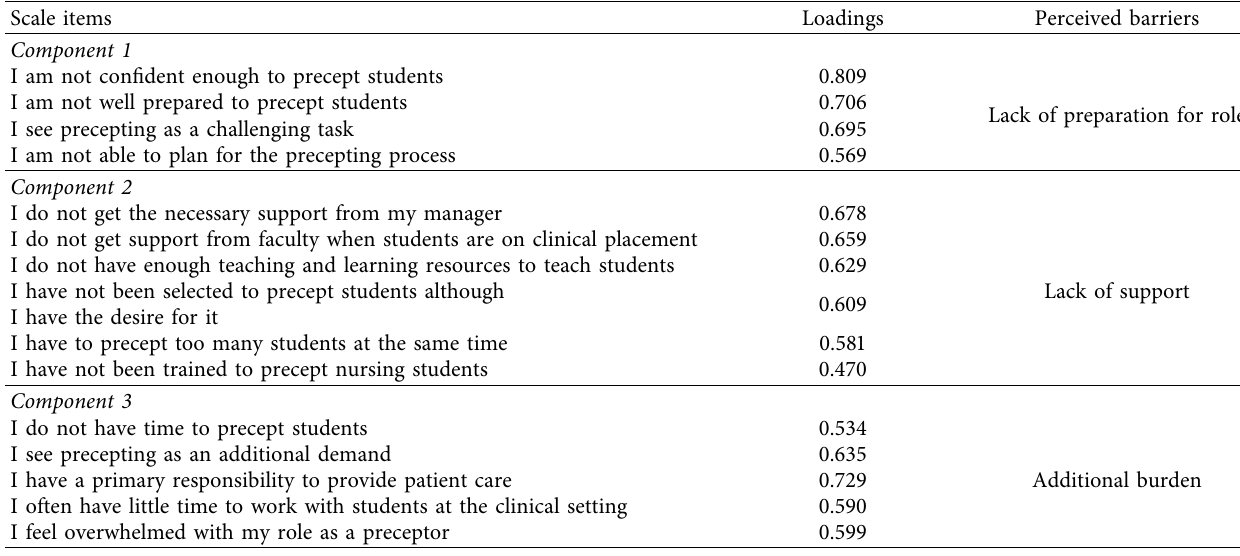
Table 5: Exploratory factor analysis on perceived barriers to successfully perform the preceptor role.